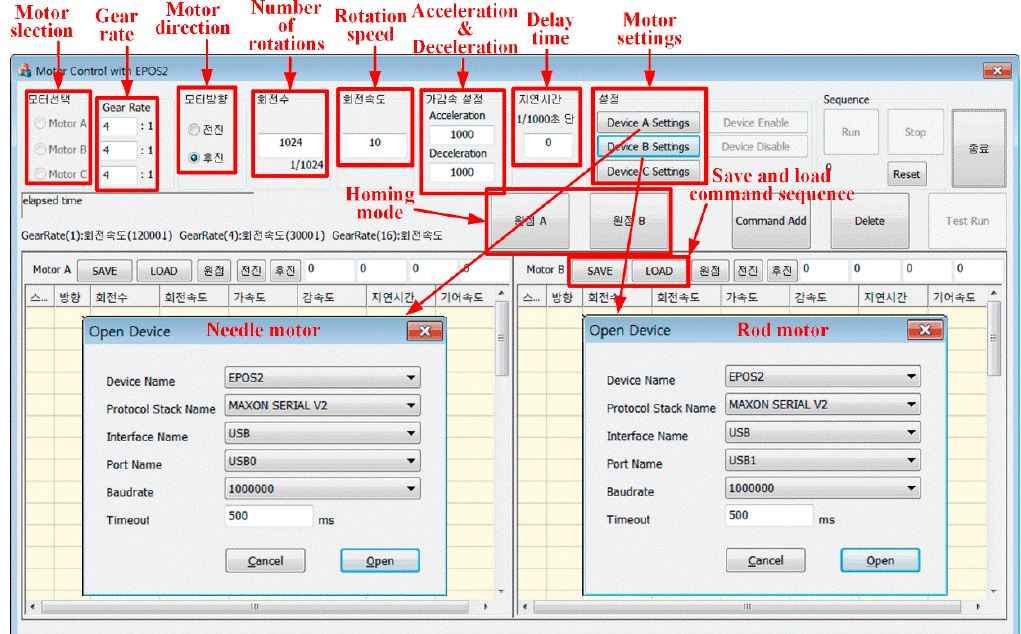
Figure 12. Proposed motor control program using the EPOS2 digital positioning controller.